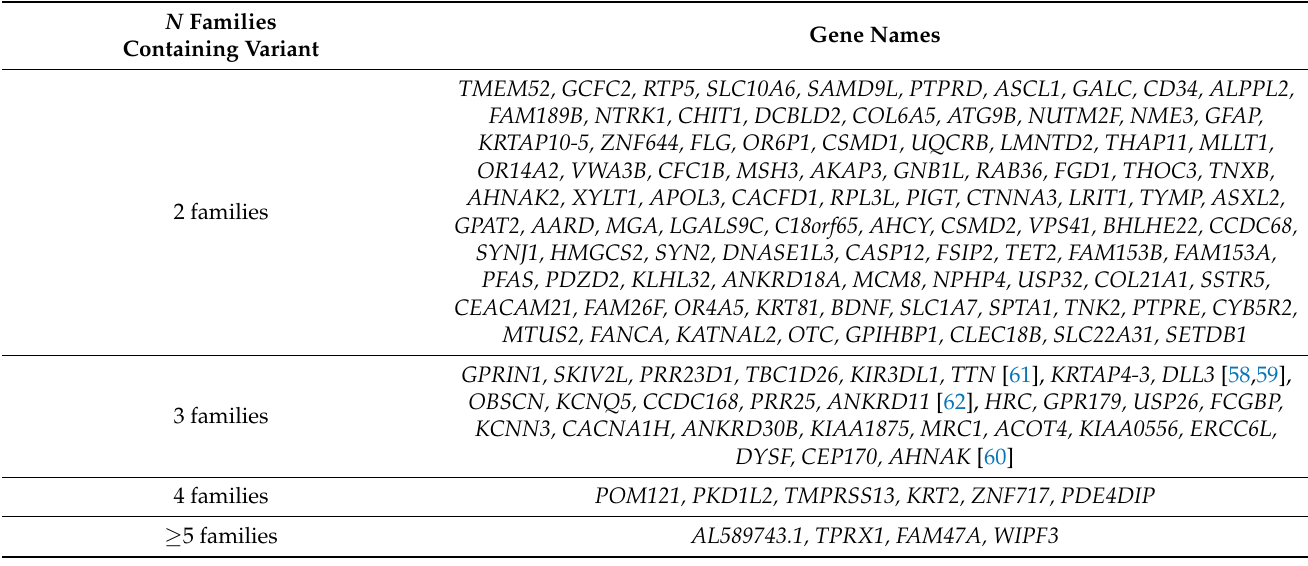
Figure 2. Summary information for total gene list ( n = 1160) of familial AIS-associated variants across families with a minor allele frequency (MAF) < 0.05 passing bioinformatic filtering, as described in the Methods. ( A ) Variant type with n variants and % of total provided. ( B ) Minor allele frequency of all variants using ExAC. ( C ) Variant counts by chromosome. ( D ) Top GO Cellular Component, 2018 terms using EnrichR. See Table 2 for top GO terms using DAVID. ( E ) Volcano plot of top enriched KEGG terms over expected. Table 1. Genes containing variants in multiple idiopathic scoliosis (IS) families. Genes with the same variant identified across families are indicated with an *. Citations are given for genes previously associated with scoliosis (including idiopathic, degenerative, or infantile). Full variant results by family are provided in Supplementary Files